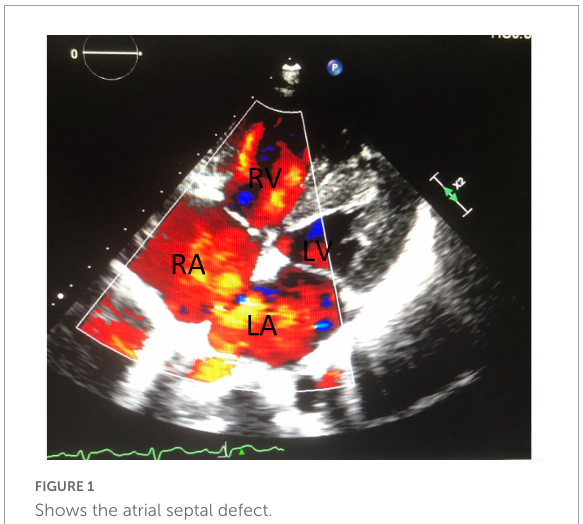
FIGURE1 Shows the atrial septal